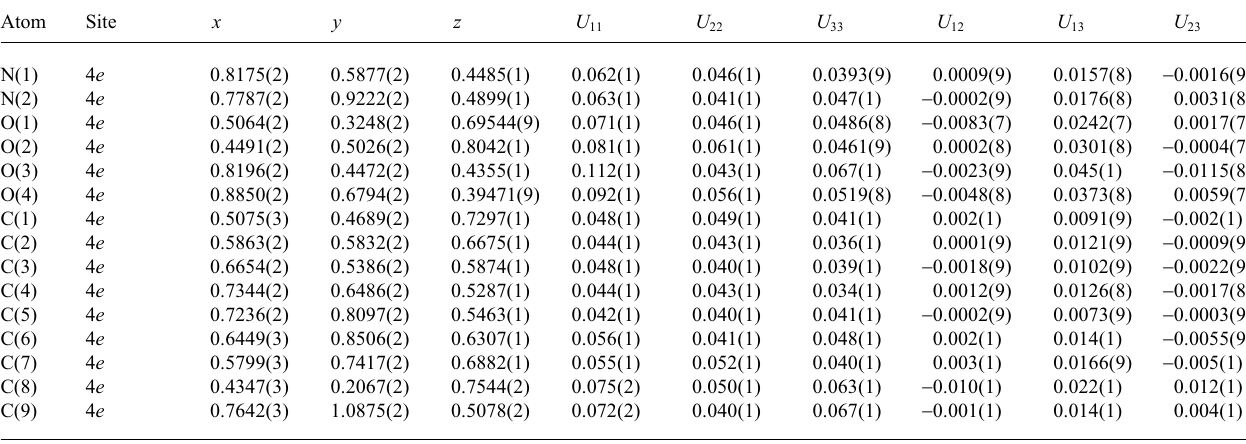
Table 3. Atomic coordinates and displacement parameters (in Å 2 )